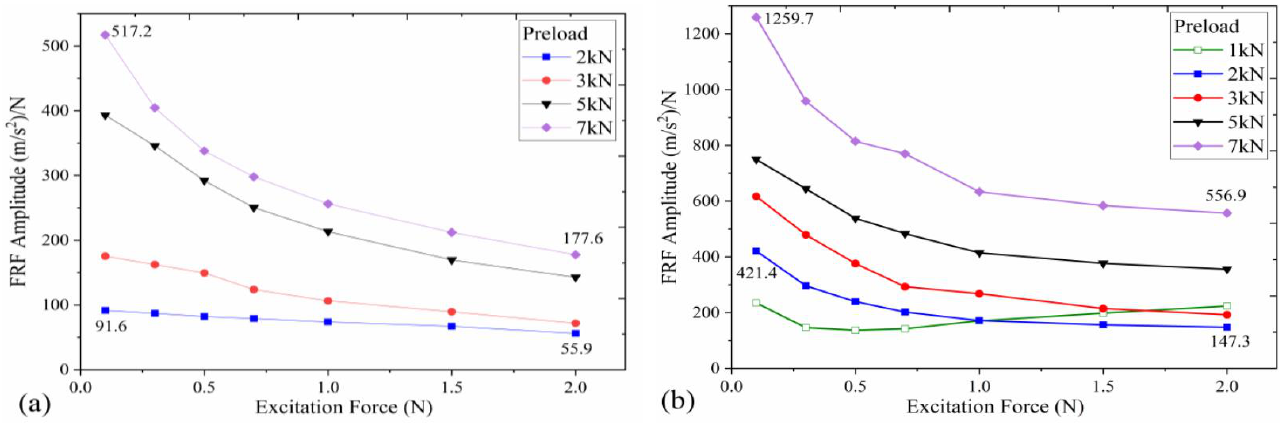
Figure 19. Characteristics of the FRF amplitudes versus the excitation force, ( a ) two-beam joint, ( b ) one monolithic beam.